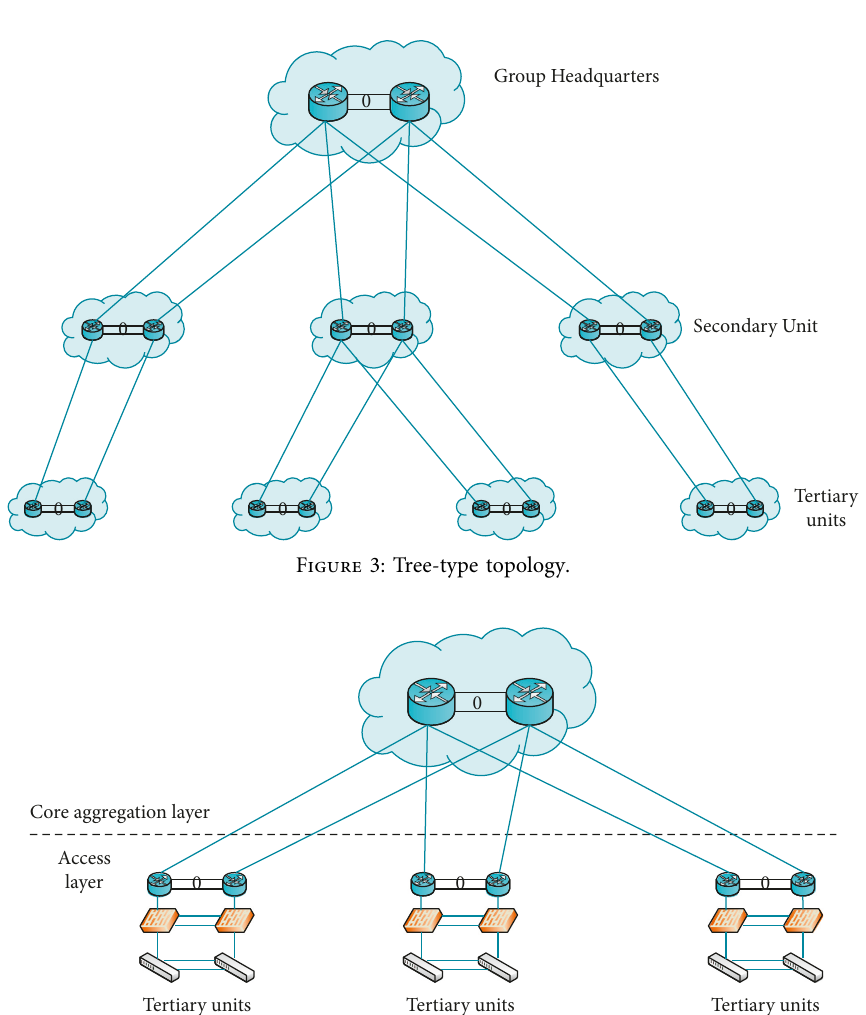
Figure 4: System unit network